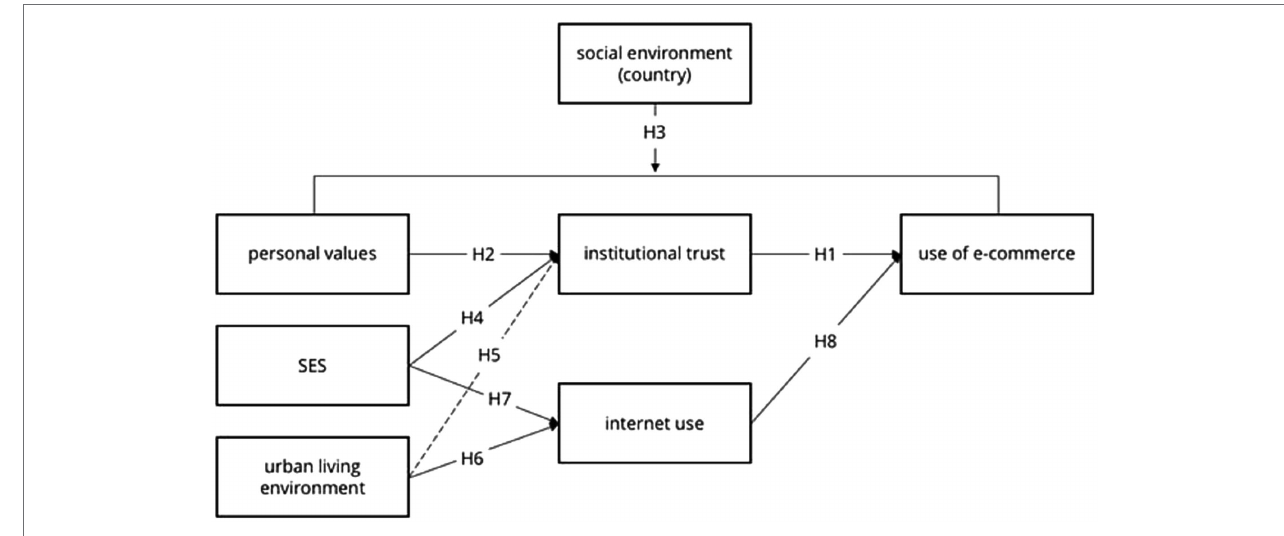
FIGURE 1 | Theoretical model of the frequency of use of e-services among young people in different cultural